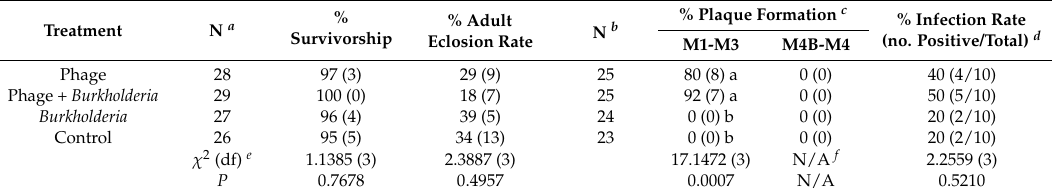
Table 1. Mean ( ± SE) values of survivorship, adult eclosion rate, and lytic phage activity of midgut homogenates from Blissus insularis that were exposed to different treatments. % Treatment N a